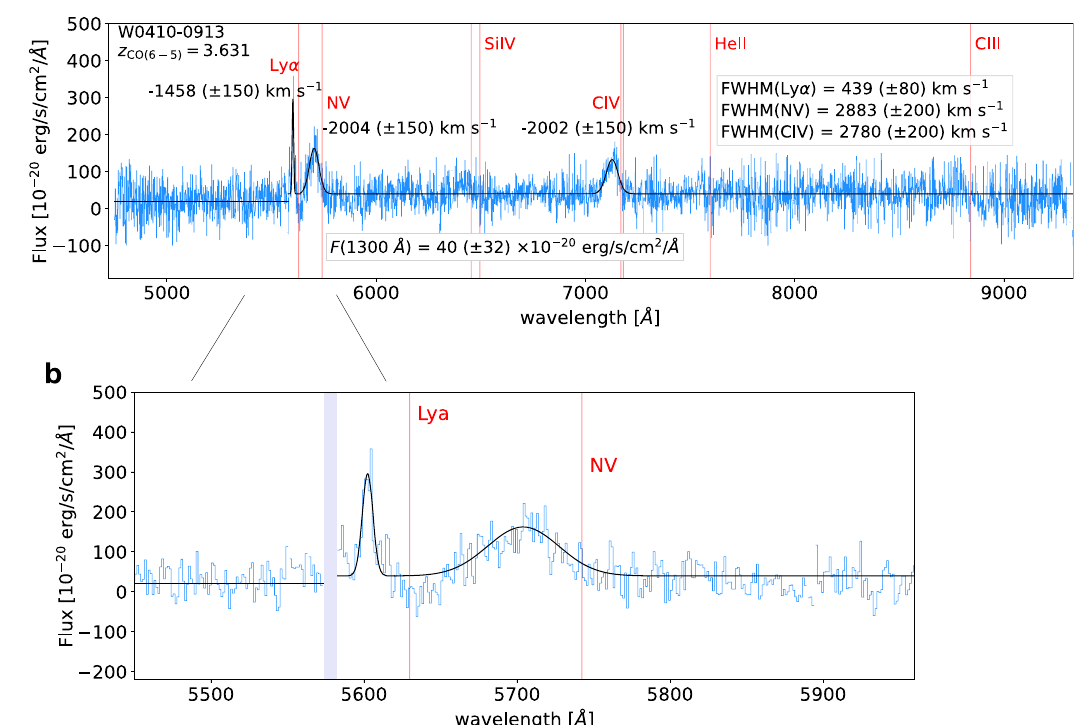
Fig. 5 | MUSE Spectrum of W0410-0913. a We show a spectrum of W0410-0913, coveringthefullMUSEwavelengthdomain,extractedfromacircularaperturewith a 1 ″ -radius. Vertical red lines are located at the expected position of several rest- frame UV lines, according to its redshift (as traced by the rest-frame FIR lines). A sigma-clipping procedure was performed to remove the residuals of sky-lines and make the visualization easier. N V λ 1240 and C IV λλ 1548,1550 show very broad line-